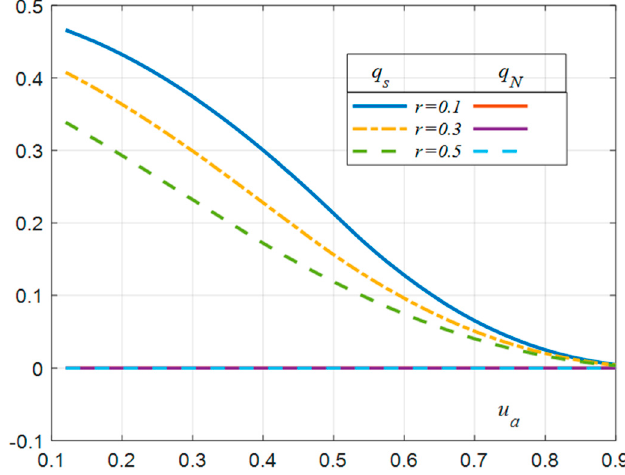
Figure 12. Dimensionless reactive powers: circuit and load nonlinearity as a function of load voltage amplitude and resistance.